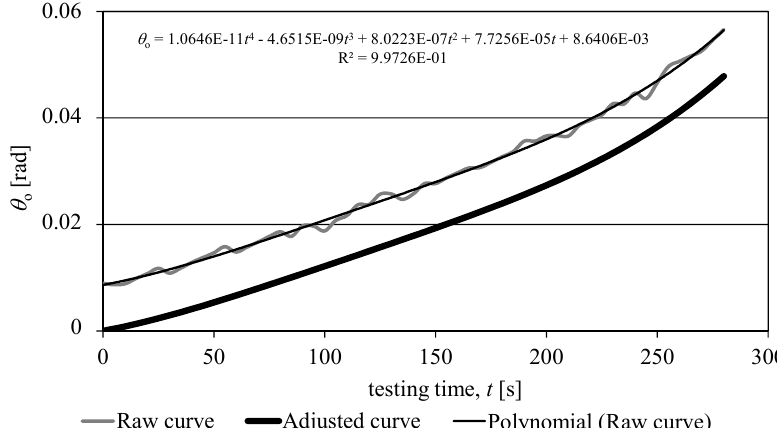
Figure 6: Evolution of  for one test specimen: raw curve obtained from the optical method, polynomial fitting curve and corrected o polynomial